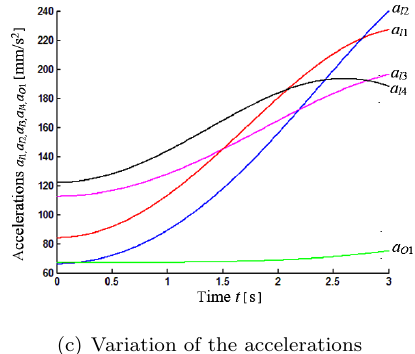
 T 500 500 500 N m  Table 5: The range of motion of the MP Description Value The range of z -displacement